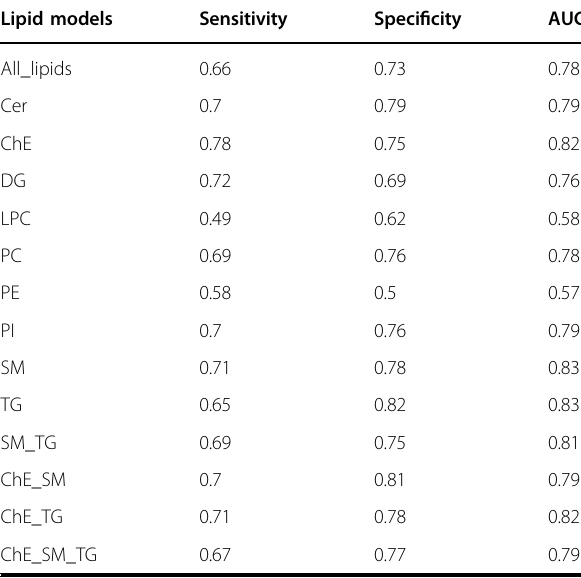
Table 2 GLMnet results of lipid models in the classi fi cation of AD versus control.